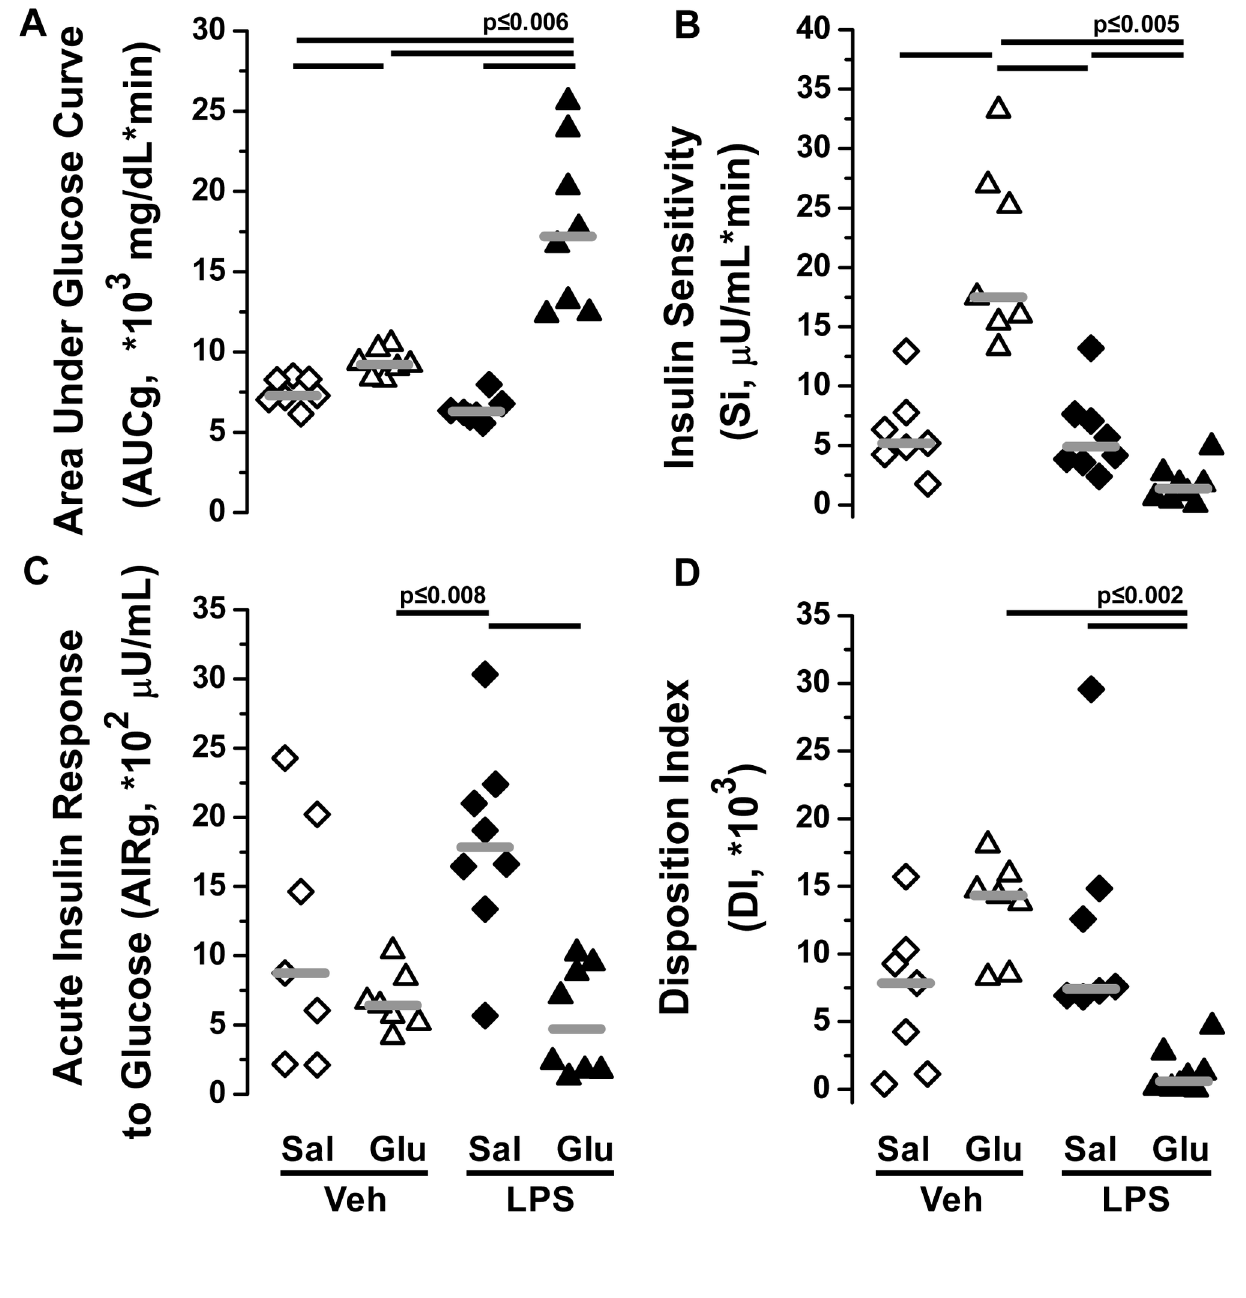
Figure 5. Minimal model data from frequently sampled intravenous glucose tolerance test. Data are shown for (A) glucose tolerance (area under the glucose curve; AUCg), (B) insulin sensitivity (Si), (C) acute insulin response to glucose (AIRg), and (D) Disposition Index (DI = Si *AIRg) for four groups of animals receiving either iv saline infusion and vehicle (Veh Sal, open diamonds), iv saline infusion and intra-arterial lipopolysaccharide (1 mg/kg, LPS Sal, closed diamonds), iv glucose infusion and vehicle (Veh Glu, open triangles), or iv glucose infusion and LPS (1 mg/kg, LPS Glu, closed triangles). Group medians are indicated by gray lines. Statistical differences were determined by Kruskal-Wallis test with differences between individual means determined by post- hoc Wilcoxon rank-sum tests corrected for multiple comparisons using the Bonferroni method.